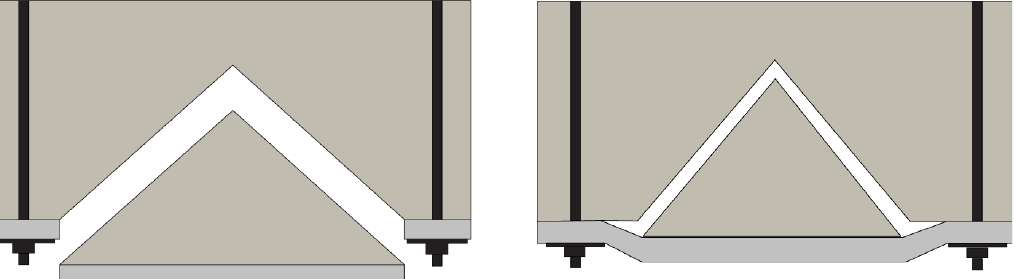
Figure 3. Examples of failure modes showing shear failure for a case with good bond strength ( left ) and flexural failure for a case with low bond strength ( right ).